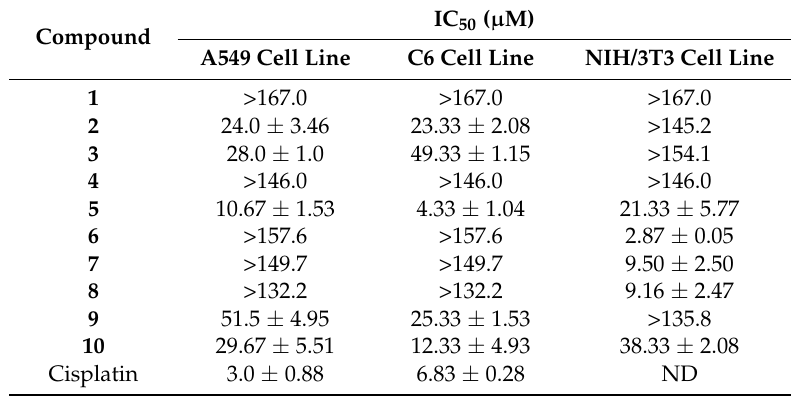
Table 1. IC 50 values of the compounds against A549, C6 and NIH/3T3 cells for 24 h. Compound